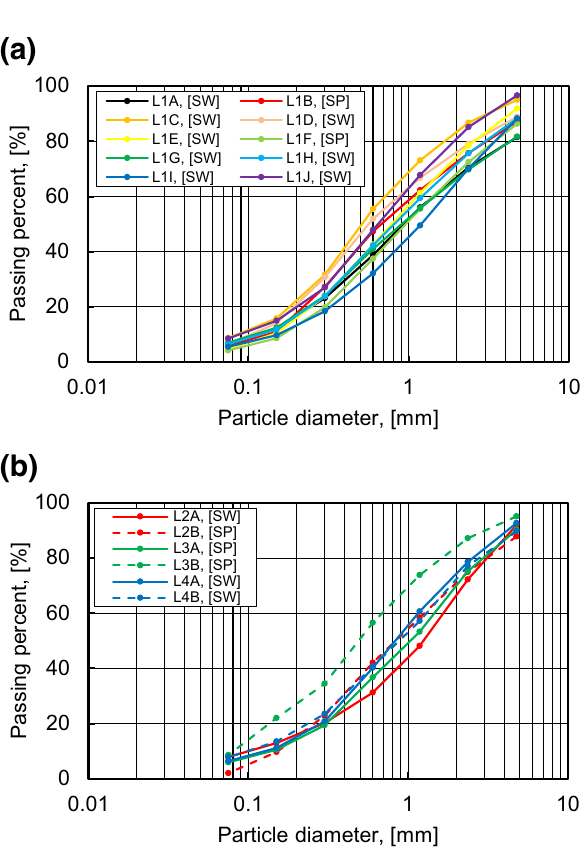
Figure 7. Grain-size distribution curves: ( a ) line 1; ( b ) line 2, 3 and